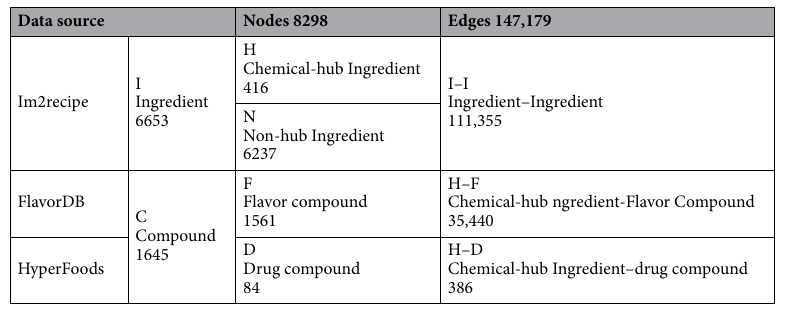
Table 7. FlavorGraph—nodes and